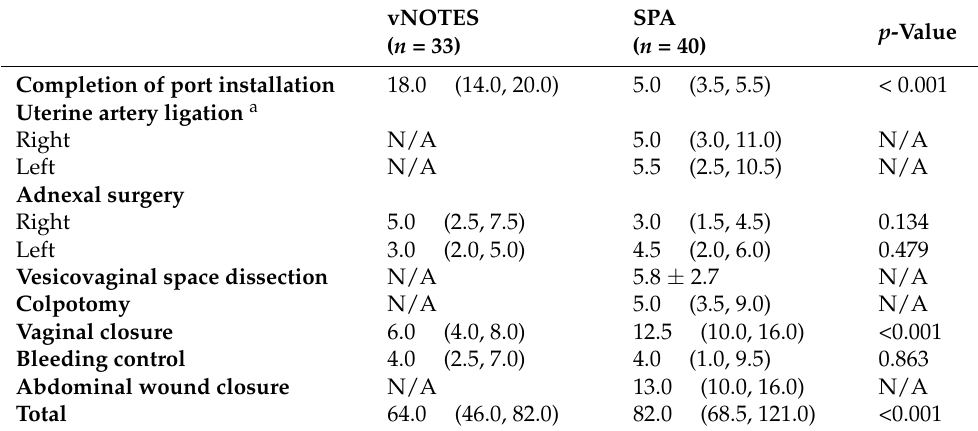
Table 3. Comparison of duration of each surgical procedure in